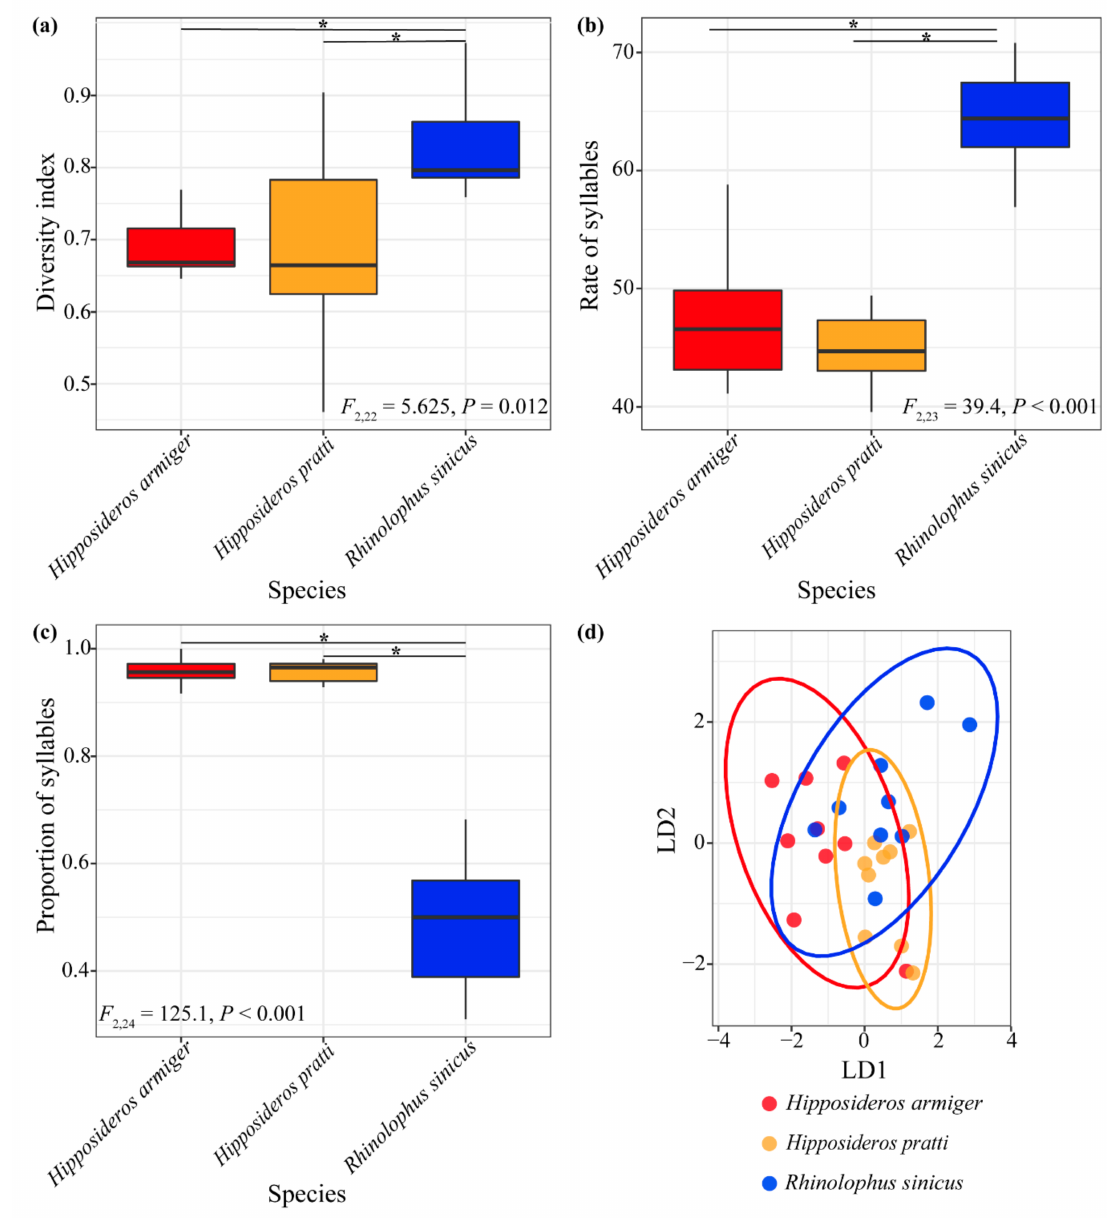
Figure 3. Di ff erences in territorial calls of Hipposideros armiger in response to invasion by sympatric bat species. ( a ) Diversity index of territorial calls; ( b ) syllable rate of territorial calls; ( c ) proportion of territorial calls that were stepped upward frequency modulation (sUFM) syllables; ( d ) ellipses showing the 95% confidence interval were obtained from a discriminant function analysis of two principal component factor scores measured from sUFM territorial calls. Colors show groupings according to species identity ( n = 3). * p < 0.05. LD1, linear discriminant function 1; LD2, linear discriminant function